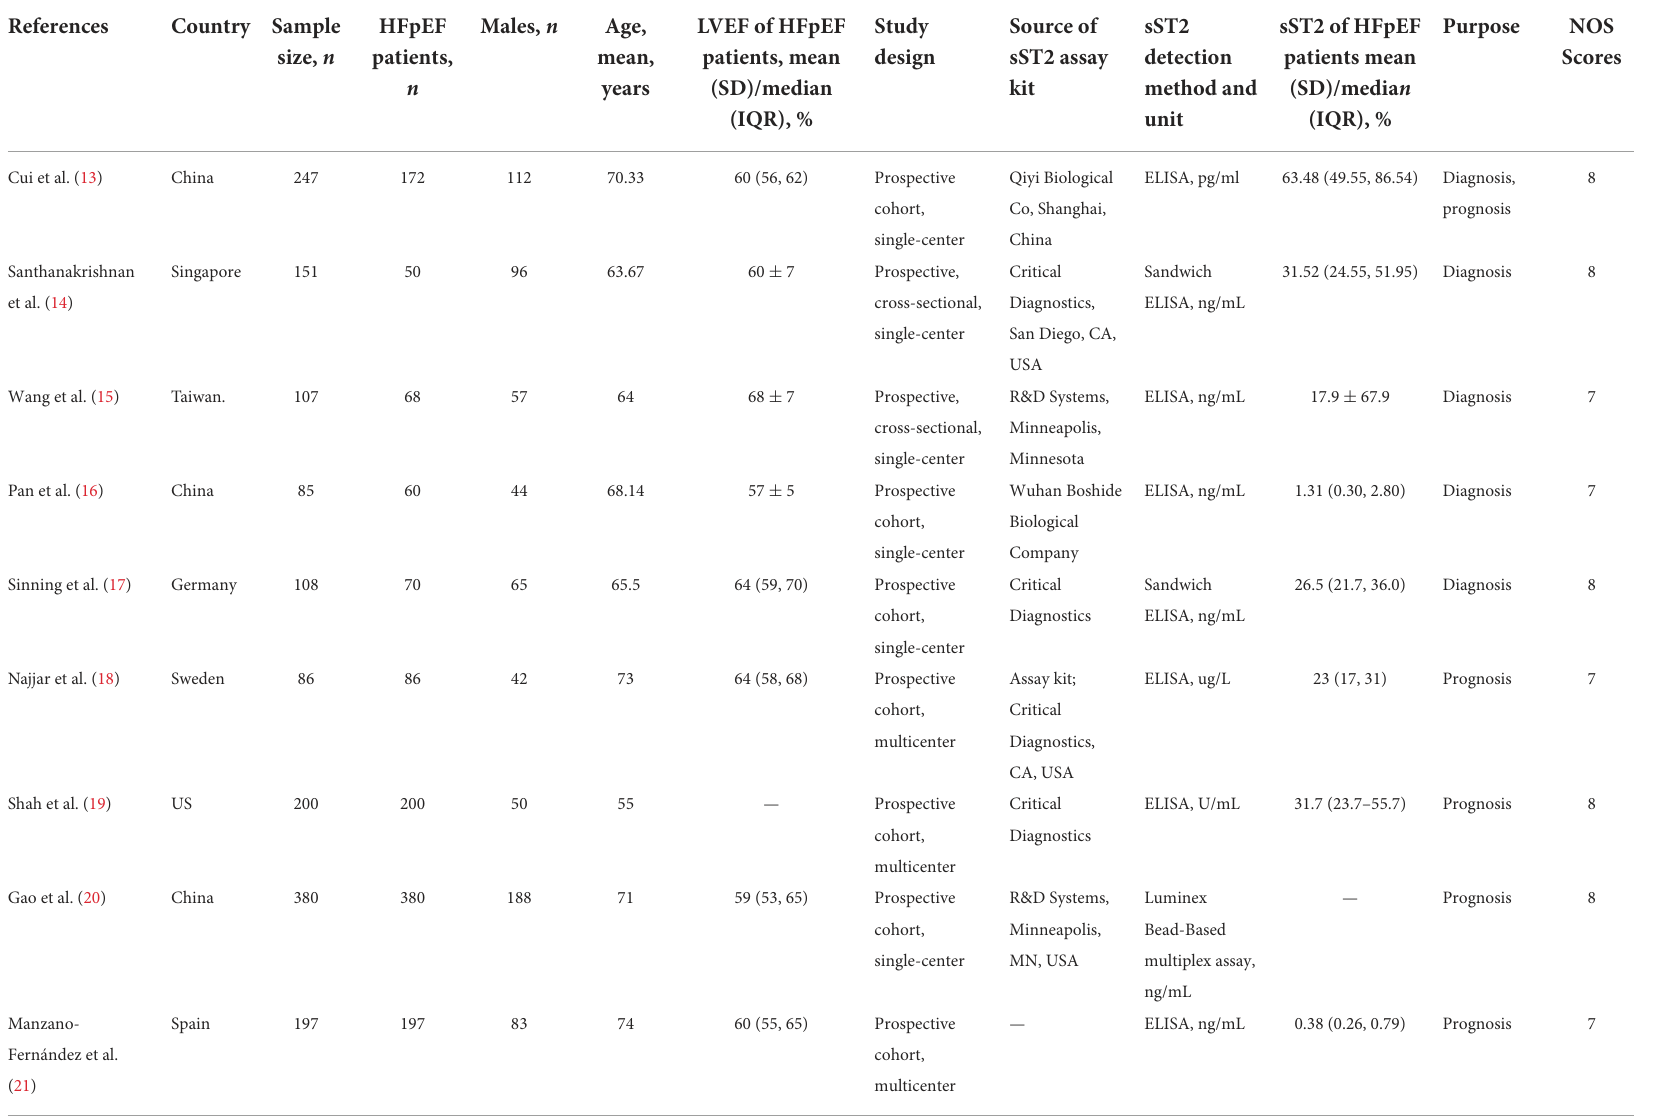
TABLE 1 Baseline characteristics of the 16 selected